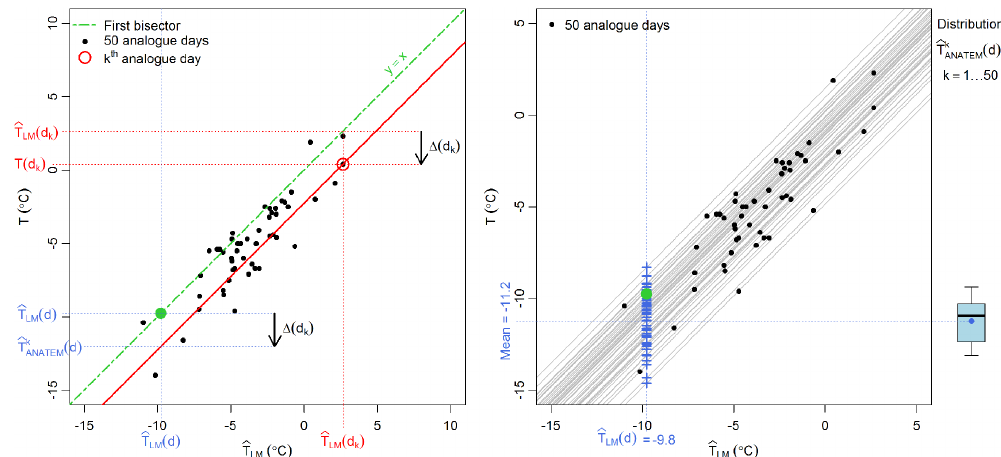
Figure 3. Representation of the ANATEM formulation for air temperature reconstruction of a given day d . Left panel: observed temperature for any analogue day as a function of the temperature estimate with LM for this day. The green point corresponds to the target day d . The red-circled point corresponds to a particular analogue day d k . For this analogue day, the corrected estimate for day d is b T k is obtained as b T LM (d) + (cid:49)(d k ) where (cid:49)(d k ) = T (d k ) − b T LM (d k ) . Right panel: probabilistic prediction obtained for d from the 50 analogues. The corresponding boxplot (10, 25, 50, 75 and 90% quantiles) is given to the right of the figure (the blue point indicates the mean value).